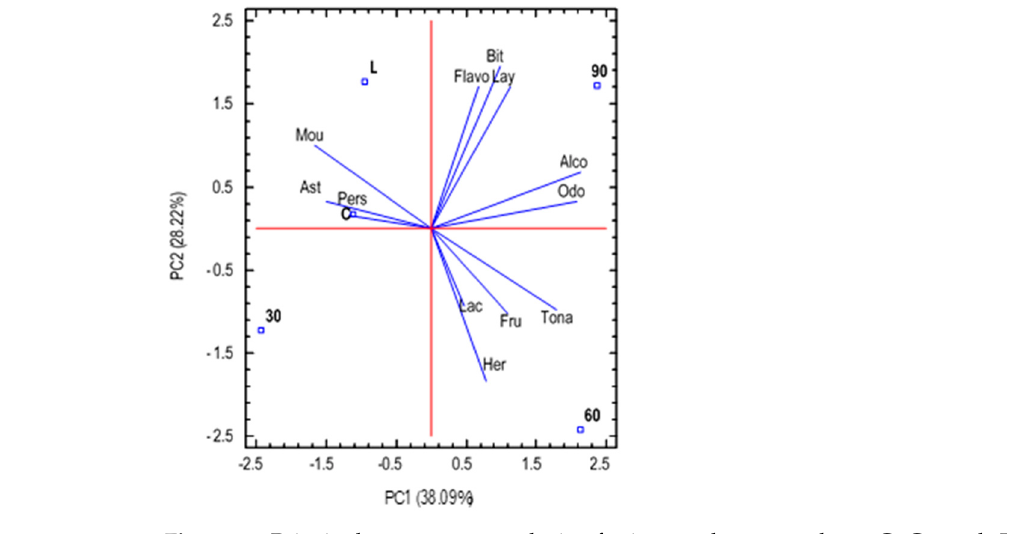
Figure 3. Principal component analysis of wines and sensory data. C: control; L: ultrasound-un- treated lees; 30, 60, 90: ultrasound-treated at an amplitude of 30%, 60%, and 90%, respectively. Code of sensory parameters (see Table